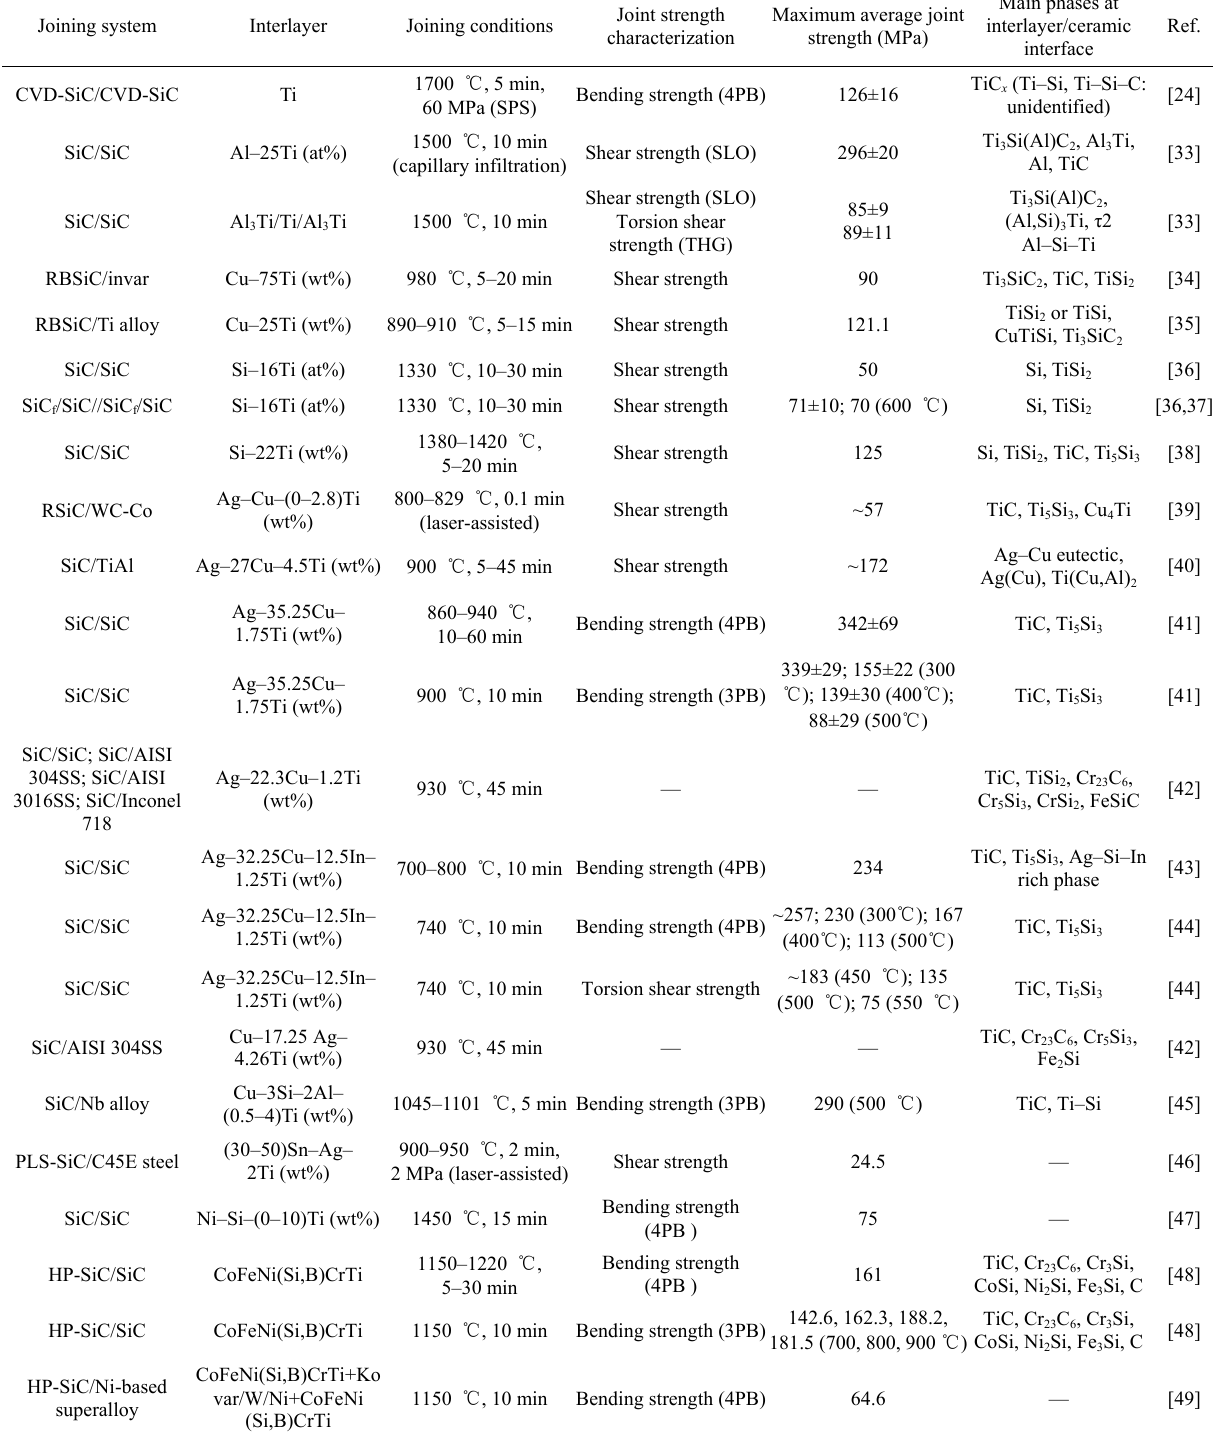
Table 2 Brazing of SiC-based materials using Ti-containing brazing fillers: interlayer, joining conditions, joint strength, and main phases at interlayer/ceramic interface Joining